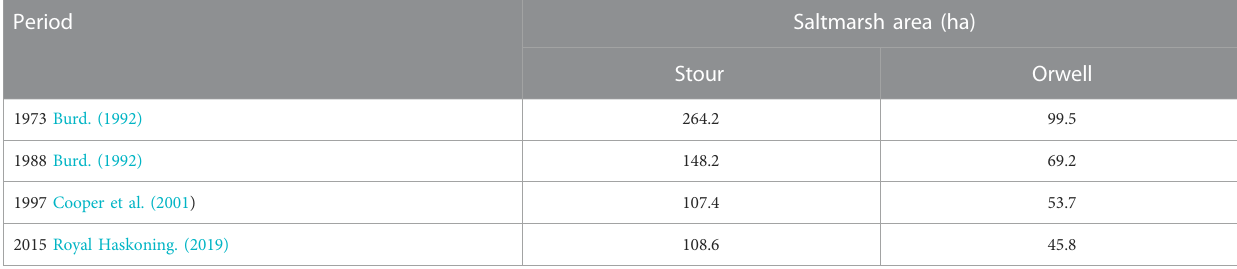
TABLE 1 Observed saltmarsh area in the Stour and Orwell Estuaries, 1973 to